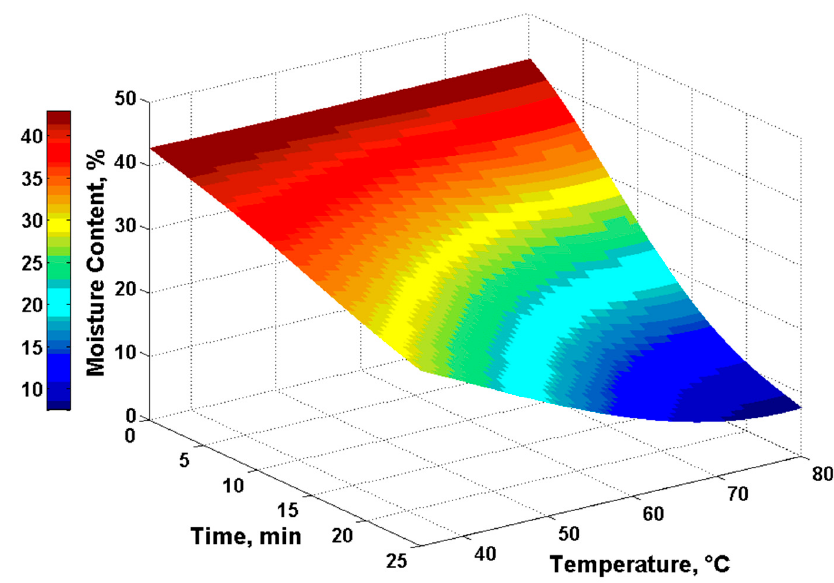
Figure 9. Drying kinetics in the torbed installation for Polish lignite.